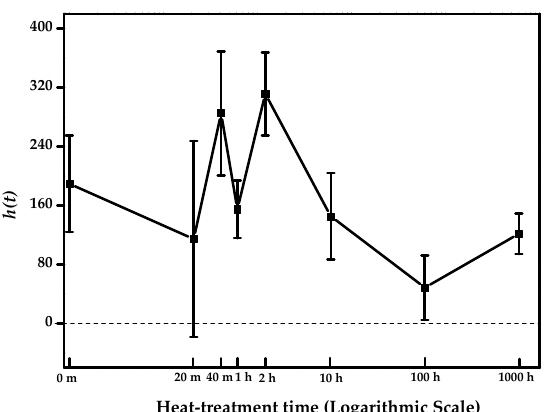
Figure 6. The dependence of the parameter of hysteretic quadratic nonlinearity on the time of thermal aging of aluminum alloy at 220 °C. Vertical bars provide a 70% confidence interval for red straight-line fitting in Figure 5.